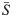
Kenyon cell degree distributions in adult D. melanogaster.(a) Distribution of number of postsynaptic partners for adult KCs. Shaded histograms: empirical distribution. Solid lines: the marginal simplex area distribution at the maximum likelihood value of α, after integrating out the number of synapses S¯ against its empirical distribution. Dotted lines: the maximum likelihood binomial distribution. (b) Lower bound for the log evidence ratio (log odds) for the fixed net weight and binomial wiring models. Positive numbers favor the fixed weight model. Evidences computed by a Laplace approximation of the marginalization over the parameters. (c) Lower bound for the log odds for the fixed net weight and bounded net weight models; positive numbers favor the fixed weight model. (d) Log likelihood of the fixed net weight model as a function of the scaling between synapse counts and net synaptic weights. (e-h) Same as (a-d) but for inputs to adult KCs.